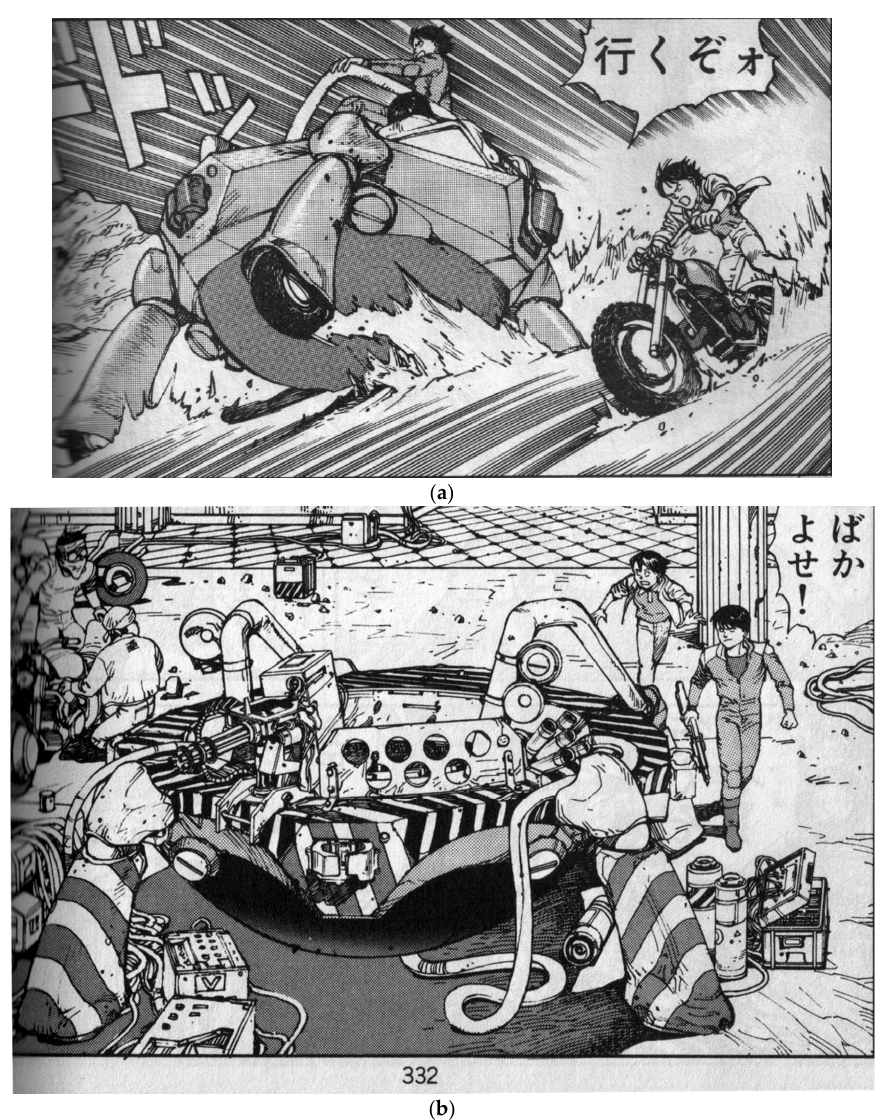
Figure 3. ( a ) panel from Katsuhiro Ō tomo, Akira (K ō dansha), vol. 5 (1990), p. 152; ( b ) vol. 5 (1990), p.